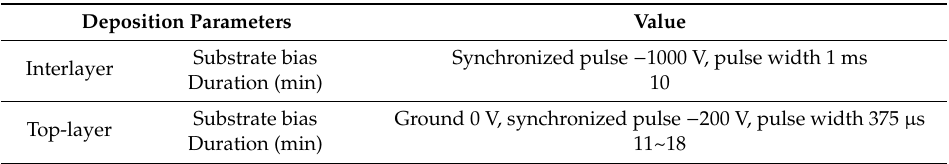
Table 2. The additional parameters for the deposition of chromium coatings, utilizing synchronized substrate bias voltage